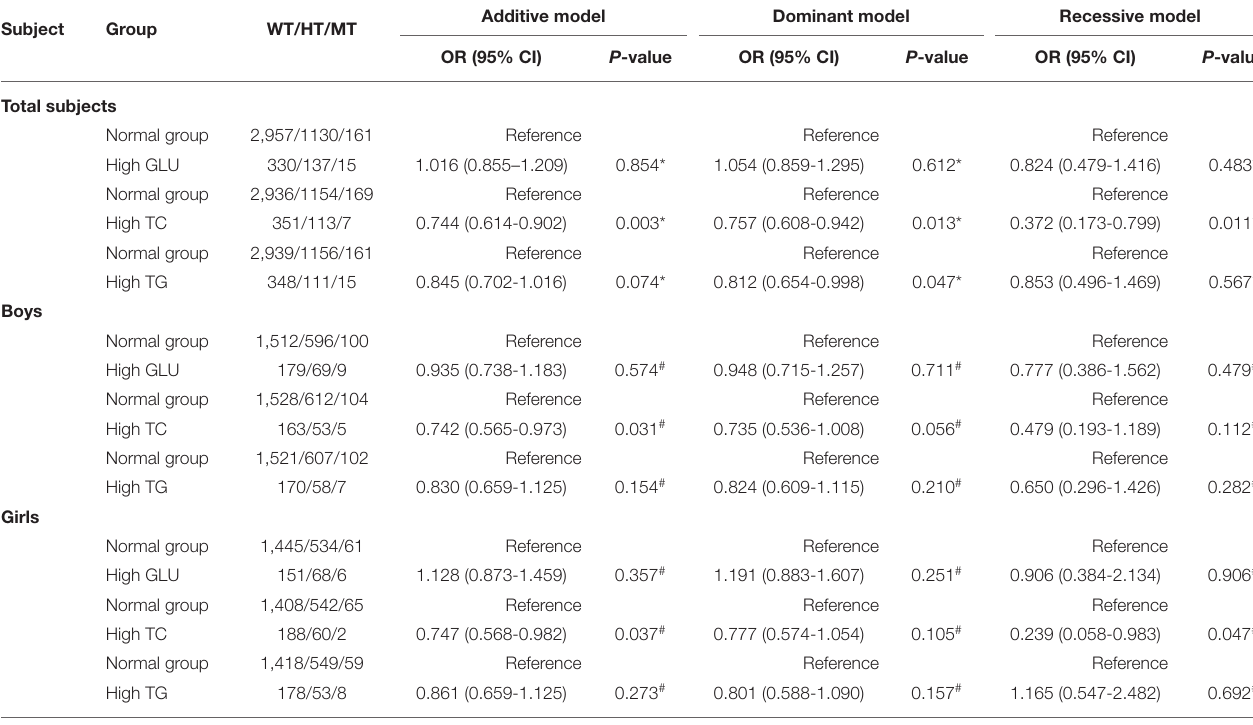
TABLE 5 | Association analysis of GHR fl/d3 polymorphism with metabolic